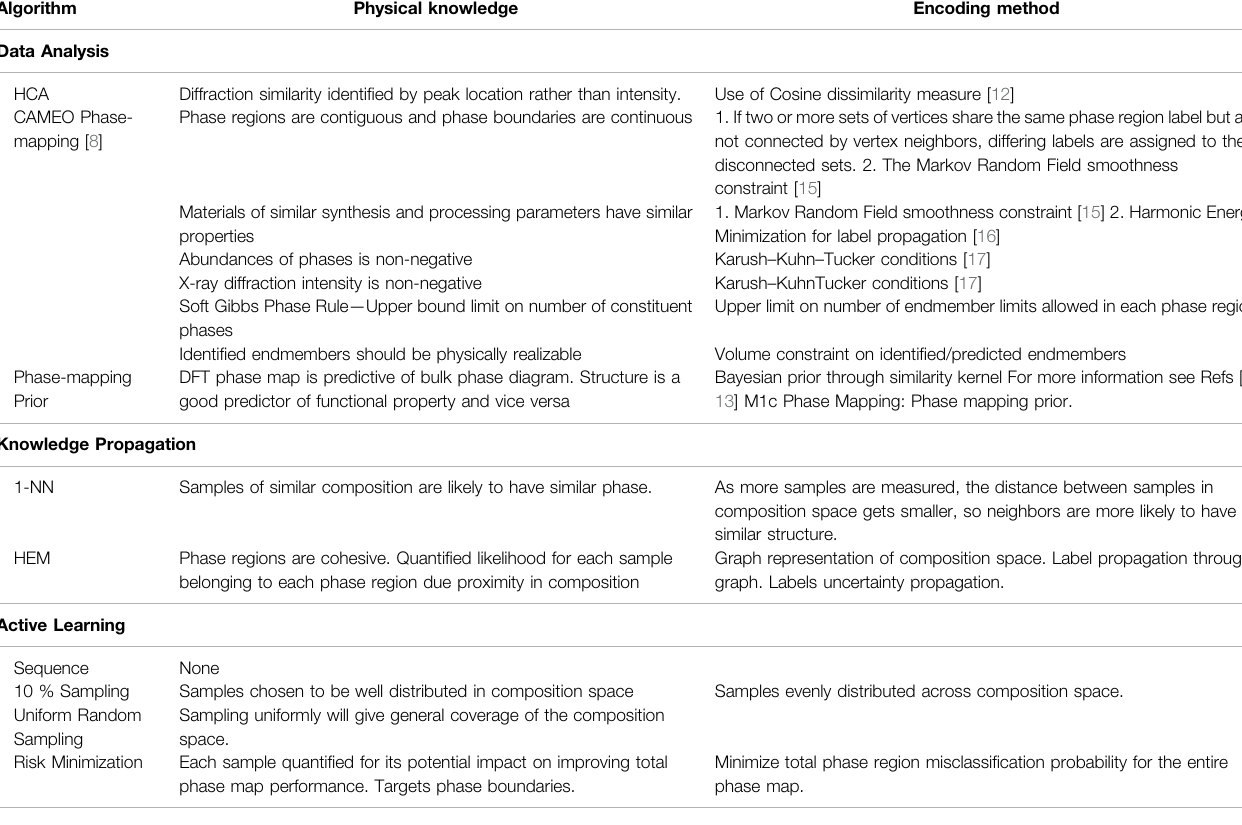
TABLE 1 | Scienti fi c AI physical knowledge and encoding method. Algorithm Physical knowledge Encoding method Data Analysis